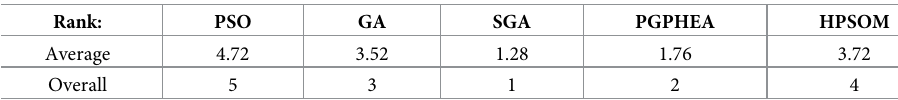
Table 9. Algorithm Ranking for CEC 2017 problems.